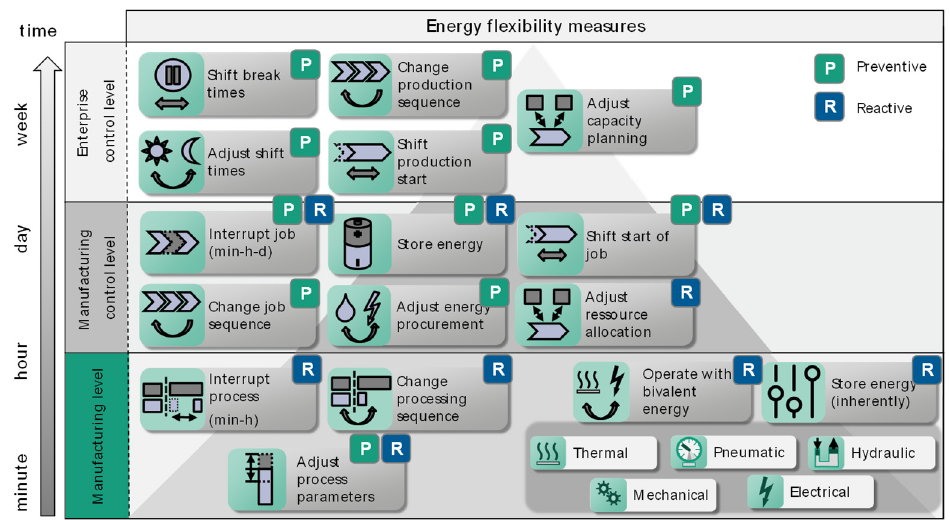
Figure 4. Energy-flexibility measures and their classification into preventive (P) and reactive (R) measures. Figure based on VDI 5207 Part 1 [37]. Reproduced with permission of the Verein Deutscher Ingenieure e. V.